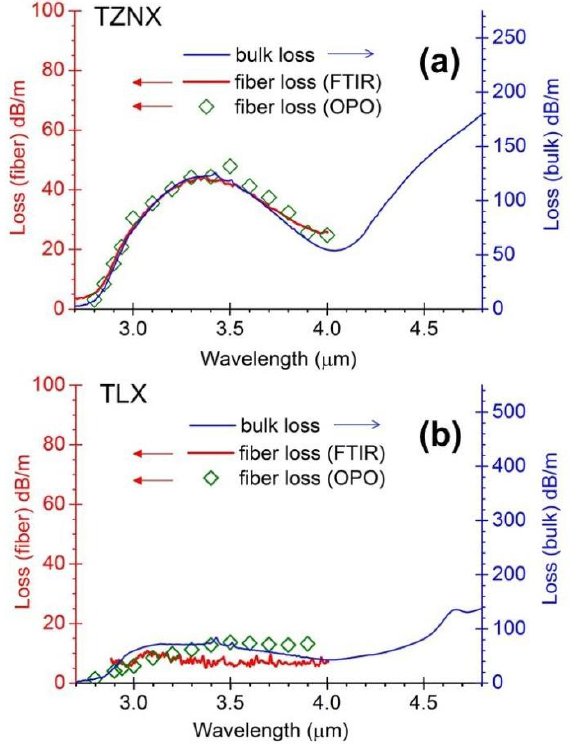
Figure 4. Comparison of OH-induced attenuation of dehydrated ( a ) TZNX and ( b ) TLX glass unclad fibers (red curve for left axis) and bulks (blue curve for right